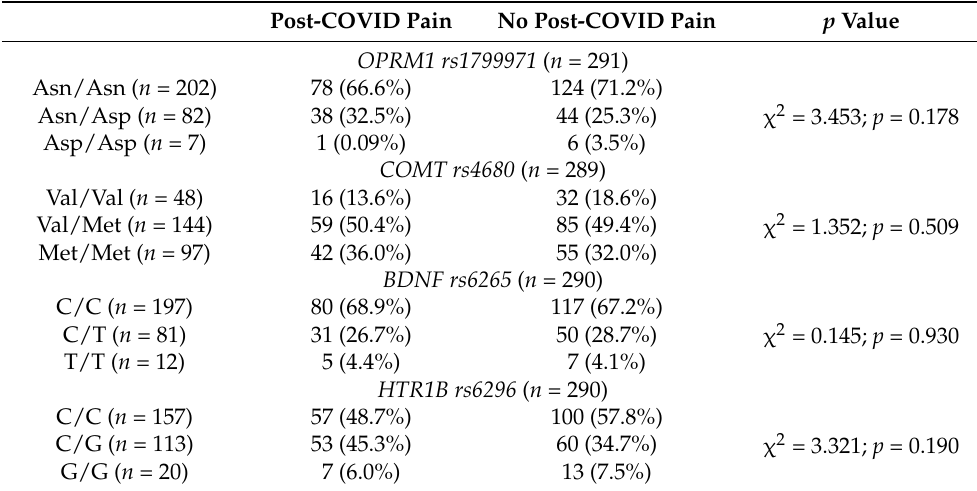
Table 2. Distribution of genotypes of the pain polymorphisms assessed in people with long COVID. Post-COVID Pain No Post-COVID Pain